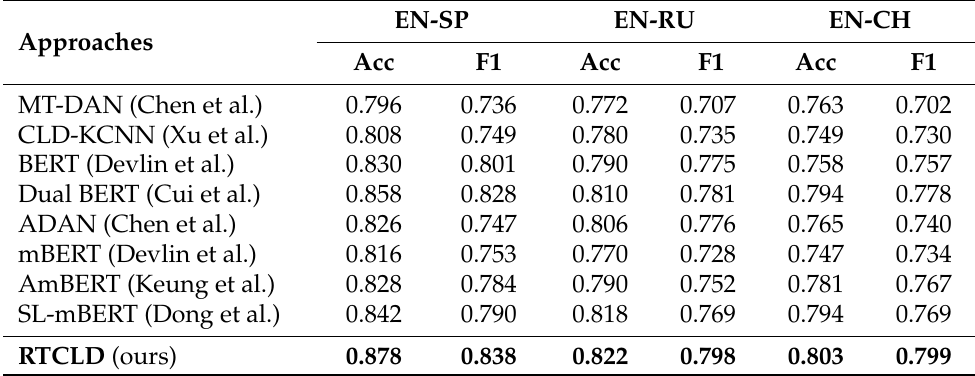
Table 2. The results of all the methods. The best scores are shown in bold.